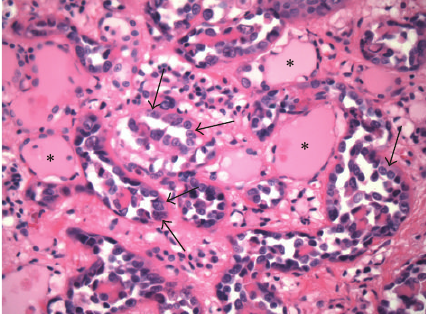
Figure 4: Left lobe of the thyroid gland. The normal thyroid follic- ular architecture (asterisks) is effaced by nests of neoplastic polyg- onal cells that occasionally form primitive follicles lacking colloid (arrows). H&E stain